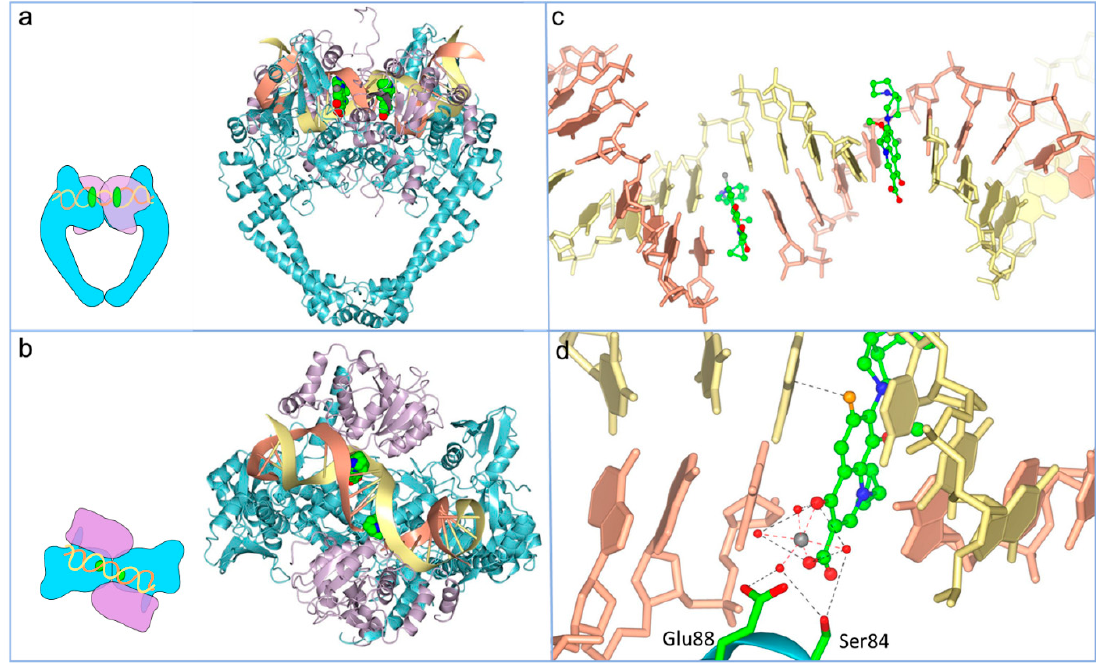
Figure 5. Overview of moxifloxacin binding to the topo IV-DNA complex (Protein Data Bank (PDB): 2XKK; [55]; figure modified with permission). ( a ) Front-faced view of moxifloxacin (Van der Waals model, green carbons) bound within the cleavage complex of Acinetobacter baumannii topo IV ParE (purple ribbons) N-terminal domain, fused to a ParC (blue ribbons) C-terminal domain and complexed with a 34-base pair (bp) heteroduplex DNA (yellow and coral ribbons). ( b ) View of the same complex from above. ( c ) Detail of moxifloxacin (ball and stick, green carbons) partially intercalated into the DNA bases at the break sites, spaced 4-bp apart. ( d ) Water-metal ion bridge formed between moxifloxacin, a noncatalytic Mg 2 + (grey sphere), four water molecules (red spheres) and S84 and G88 of ParC.